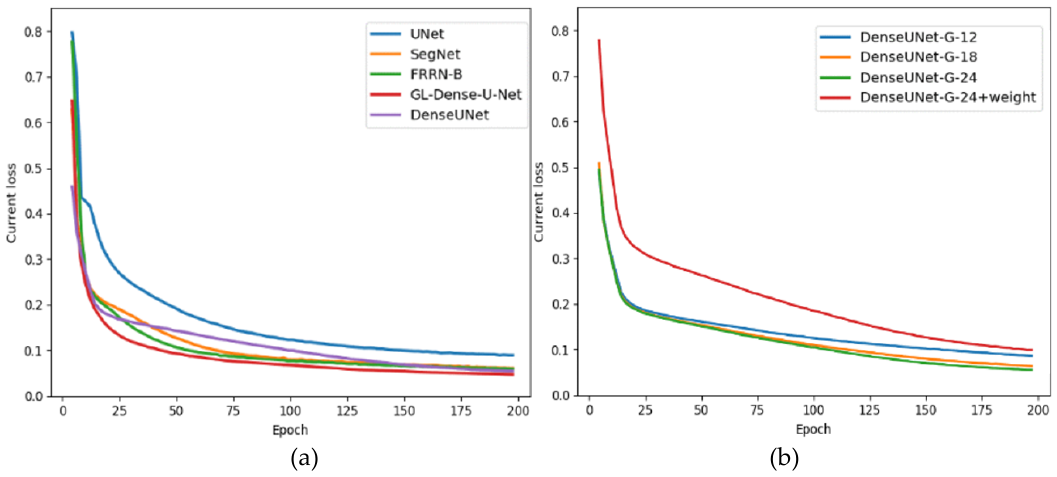
Figure 9. Loss of training. ( a ) The five curves of blue, yellow, green, red and purple represent the losses of U-Net, SegNet, FRRN-B, GL-Dense-U-Net, and DenseUNet; ( b ) The four curves represent models with different growth rates and modified weights